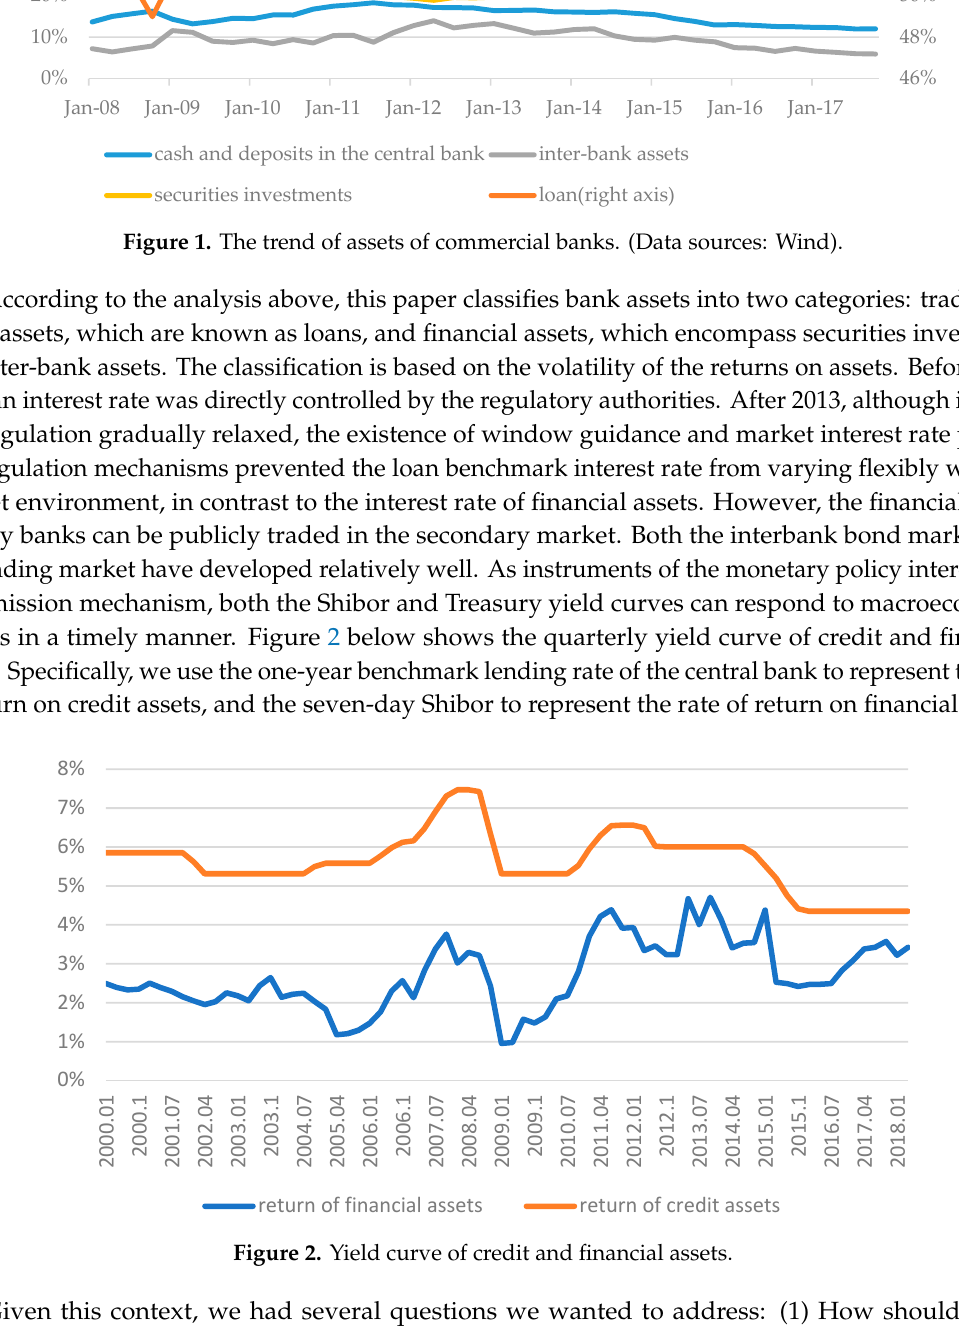
Figure 1. The trend of assets of commercial banks. (Data sources: Wind).